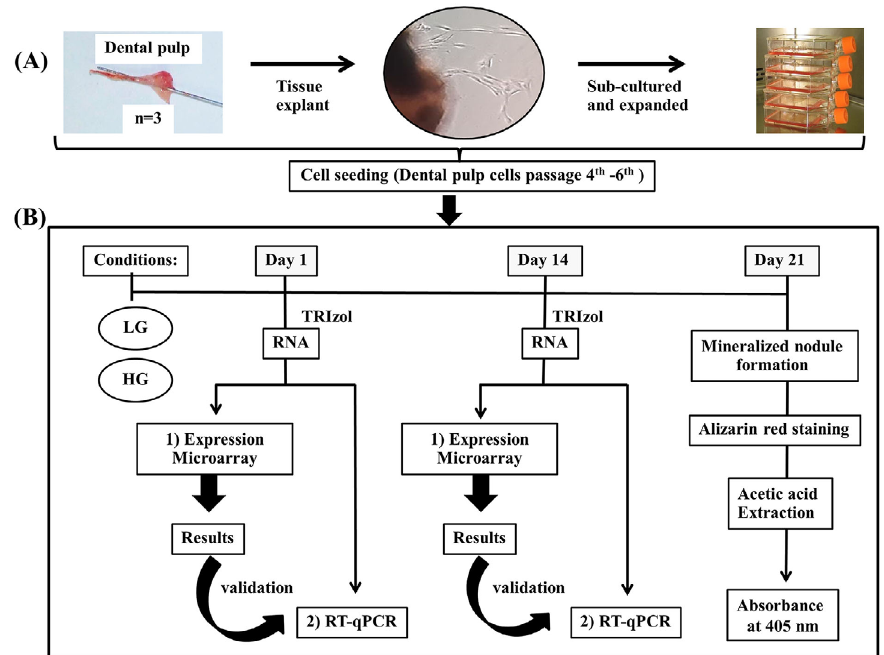
Figure S1- Experimental flow chart. (A) Isolation of human dental pulp-derived cells using tissue explant technique. (B) Cell mineralization, RNA isolation and analysis of gene